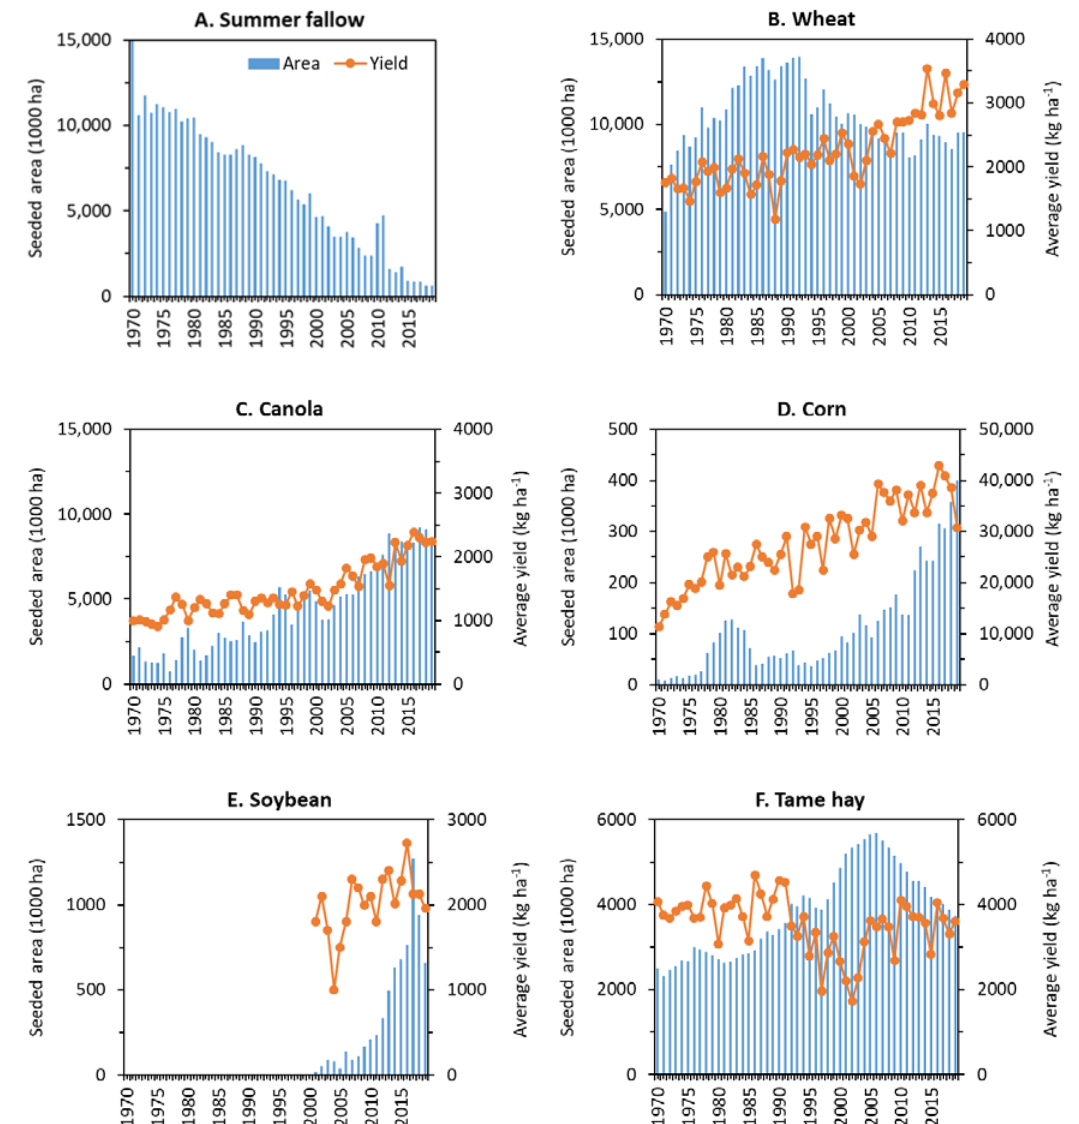
Figure 3. Total seeded area and average yield for major field crops in the Canadian Prairie provinces of Manitoba, Saskatchewan and Alberta from 1970 to 2019 (data source: Statistics Canada [5]). Wheat includes winter wheat, spring wheat and durum. Corn seeding area is the sum of areas for both corn grain and corn silage, while only the yield of corn silage is presented in the figure.